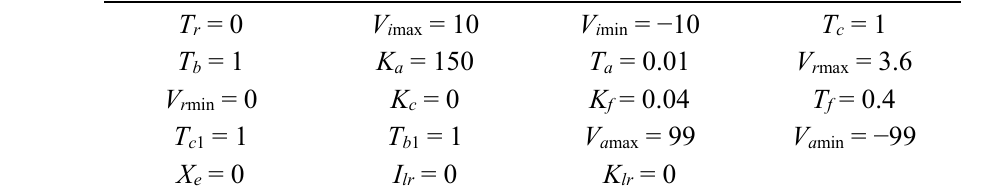
Figure 6. Block diagram of EXST1 exciter. Table 2. EXST1 Exciter model parameters.